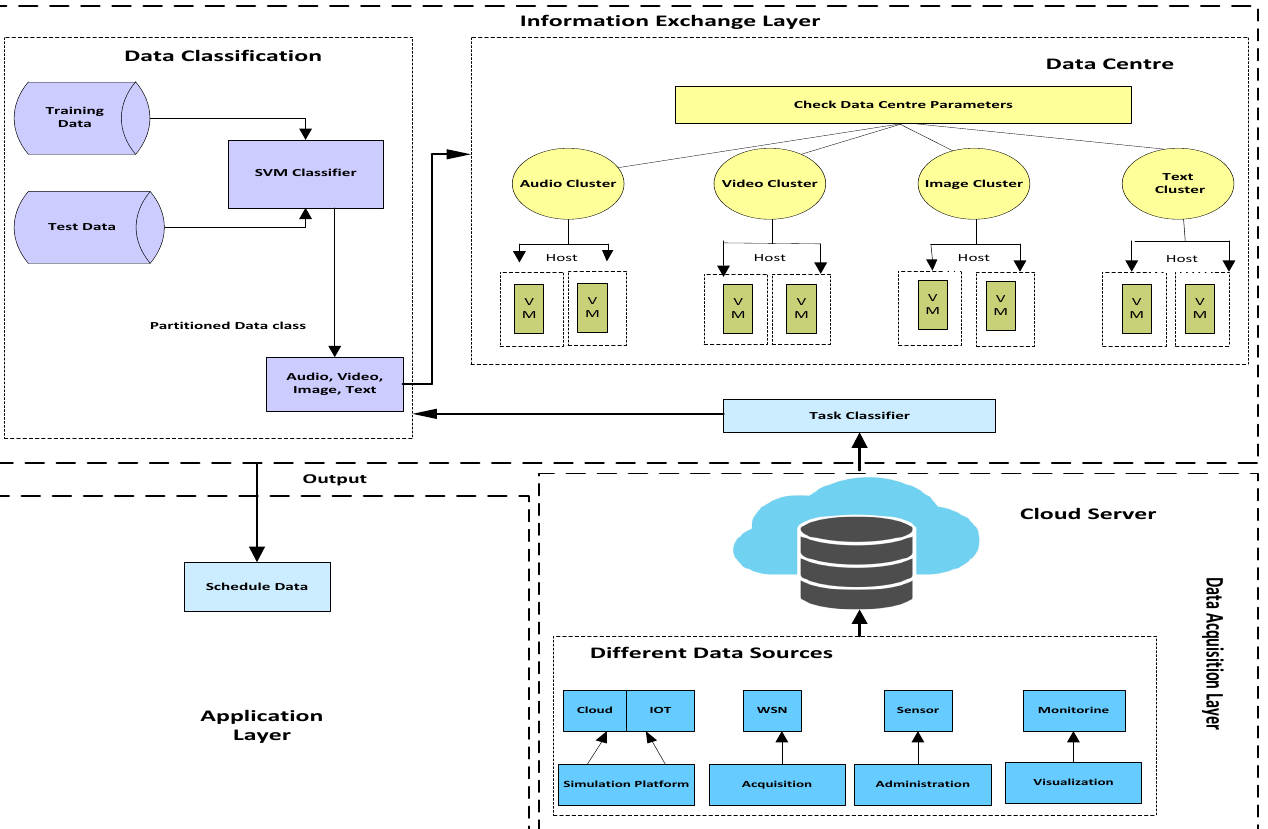
Figure 1. The flow of activities for the AGRICLOUD.